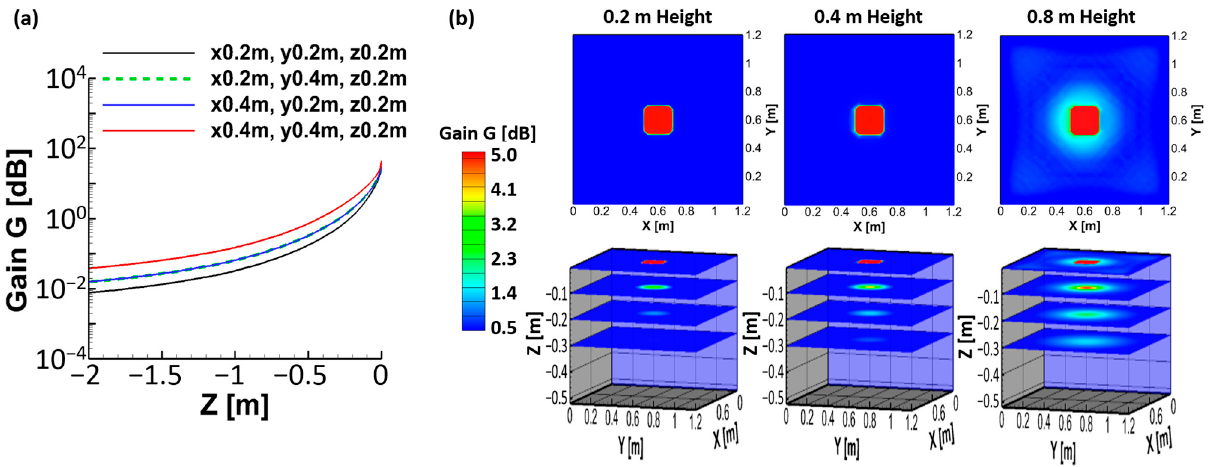
Figure 5. The G values for ( a ) different sizes of PEC inside box as a function of width ( x ), length (y), and height ( z ). ( b ) 0.2, 0.4, and 0.8 height with 0.2 width and 0.2 length on xy plane at z = − 0.005 m and xyz geometry. The relative permeability of the inside box is fixed at 1.